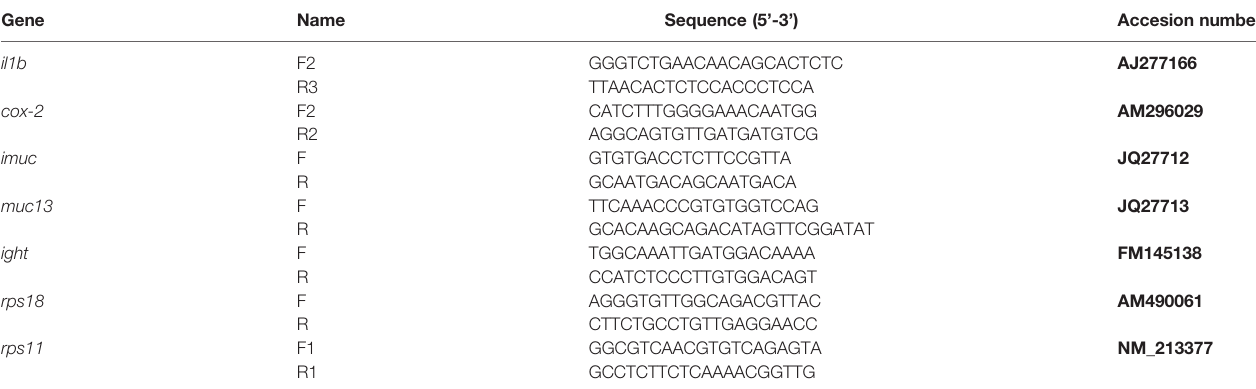
TABLE 1 | List and GeneBank accession number of primers used for qPCR analysis of seabream